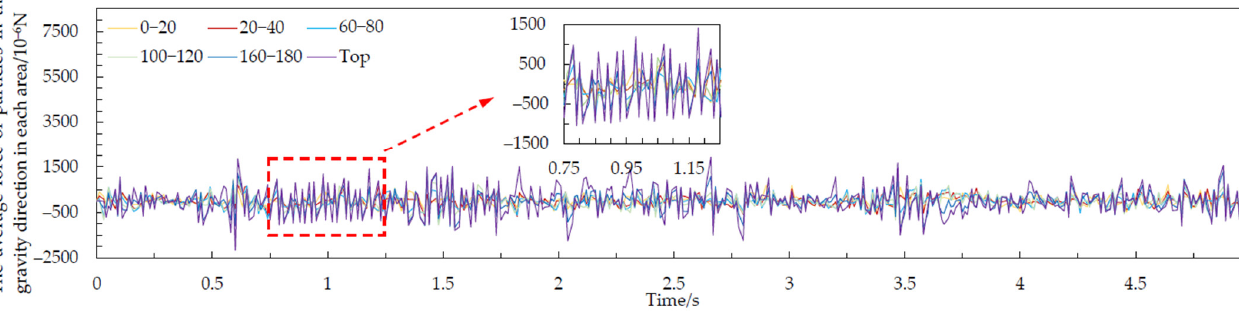
Figure 9. Average force of the corn grain in different areas over 0–5 s.